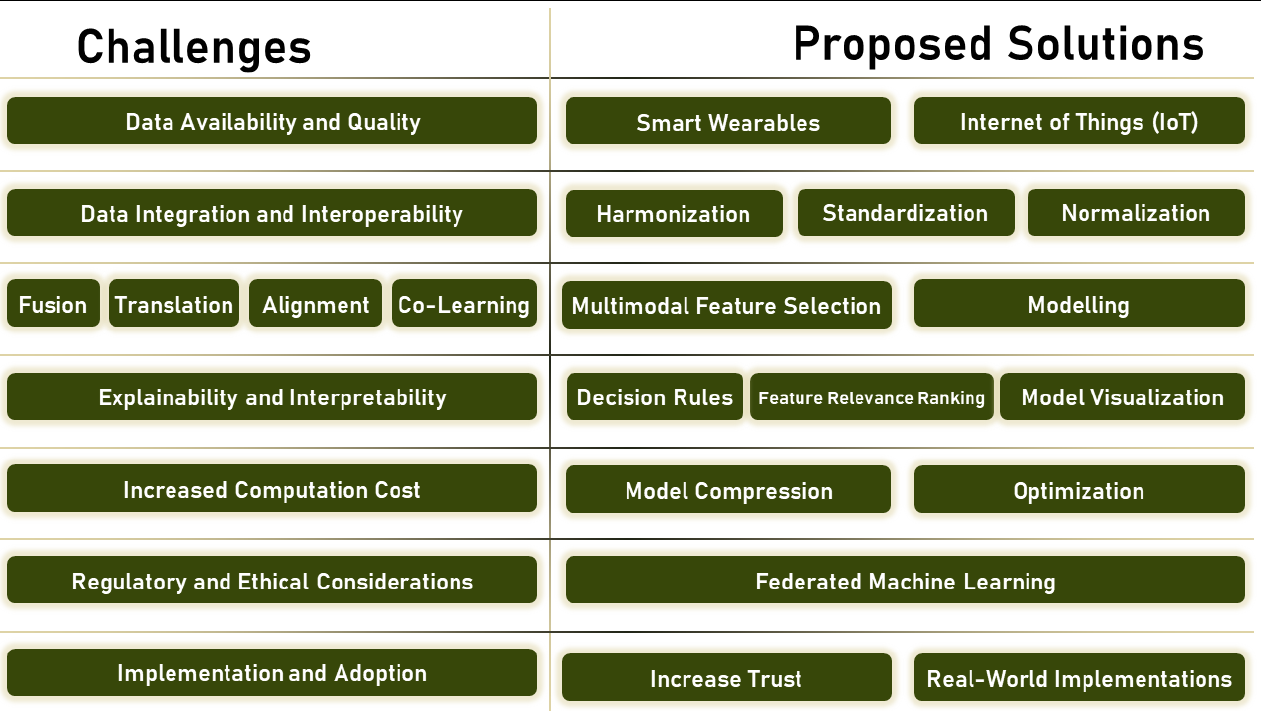
Figure 6. Multimodal machine learning challenges–solutions